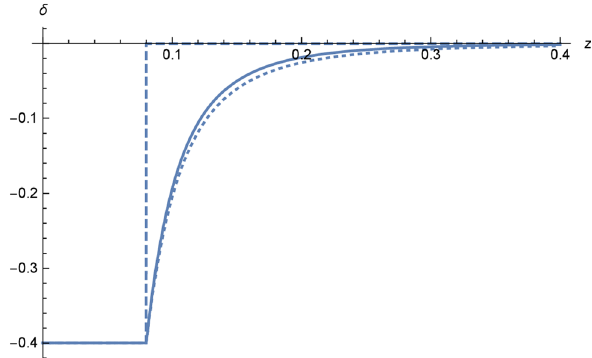
Fig. 1 Plots of the step density contrast δ (dashed) defined in Eq. (6), its volume average δ (solid) in Eq. (7), and the approximation (dot- ted) obtained by dropping the term ( 1 + z v )/( 1 + z ) , for z v = 0 . 08 and δ v = − 0 . 4. The inhomogeneity effects are proportional to δ , and extend beyond the edge of the void, but are suppressed beyond the edge, implying that high redshift observations are not affected by the local